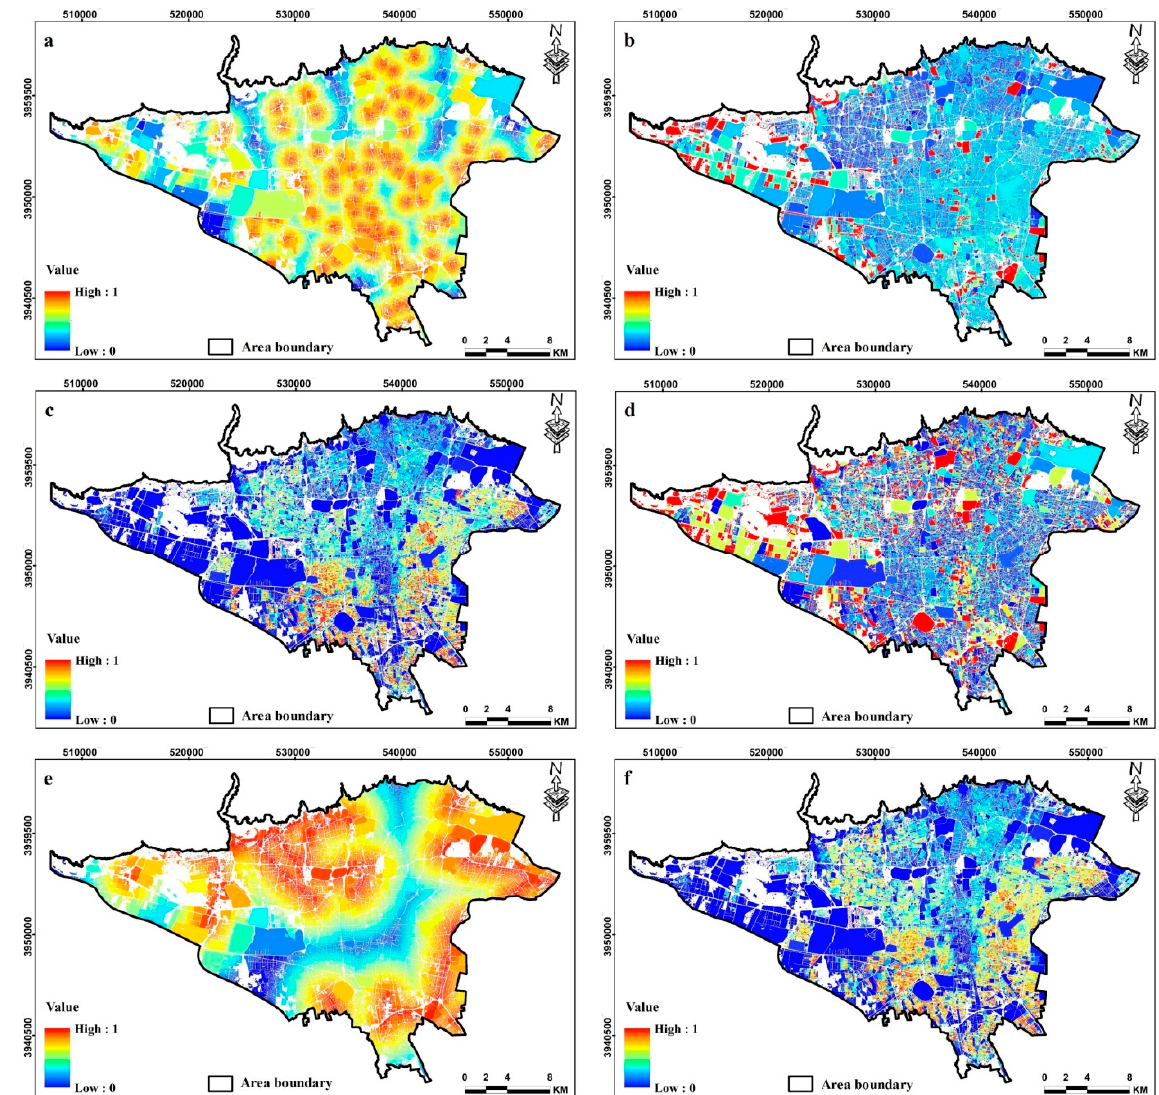
Figure 9. Fuzzification map of sensitivity criteria: ( a ) average distance from fuel station; ( b ) skeleton type; ( c ) vulnerable population density; ( d ) material type; ( e ) average distance from power transmission lines; ( f ) total population density.